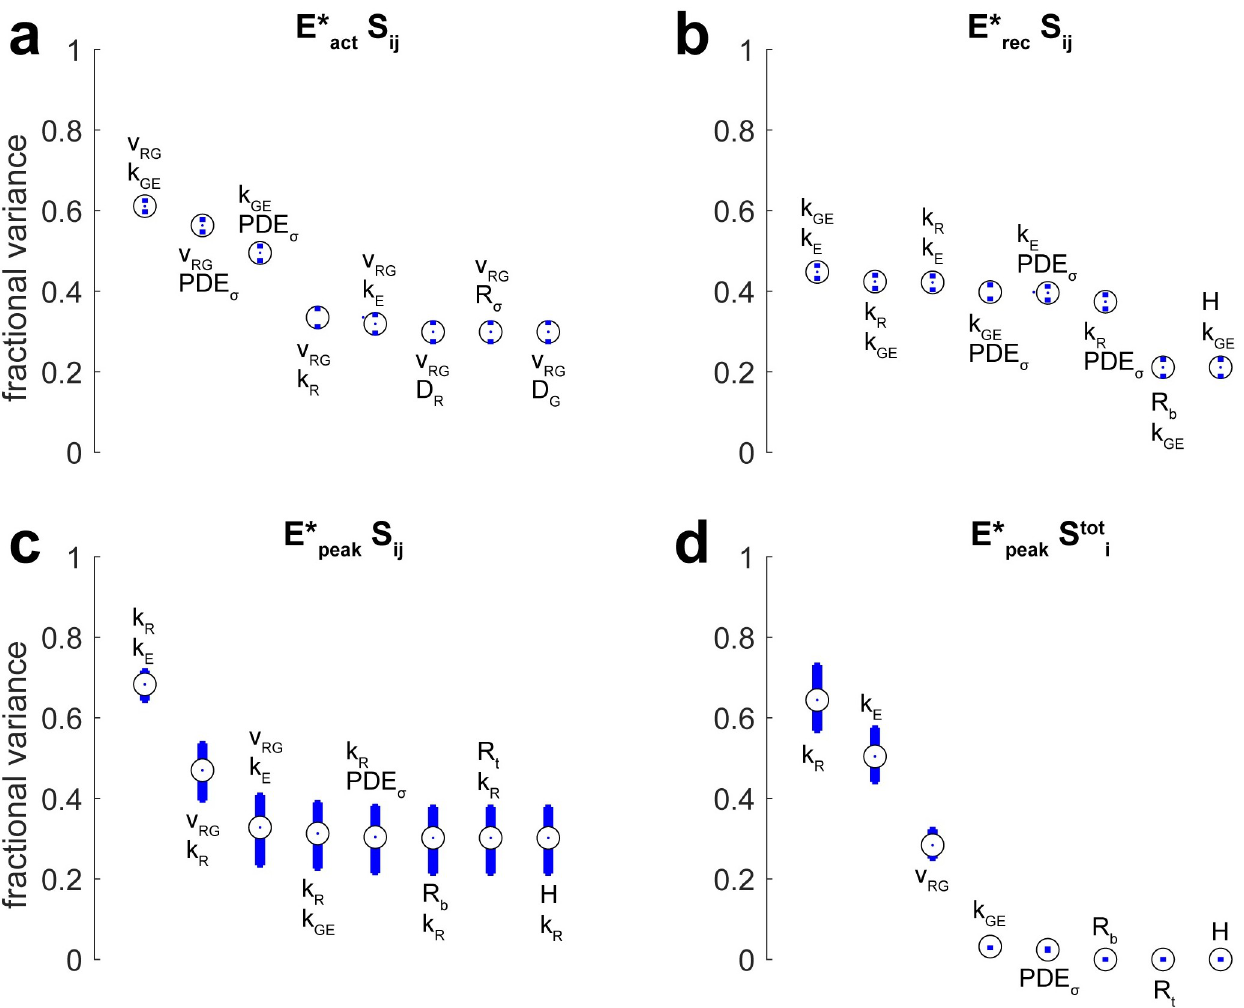
Fig 2. Sobol indices for functionals quantifying E � . The dot at the center of a circle is the Sobol index obtained by Monte Carlo evaluation (100,00 samples). The blue bars define a 90% confidence interval. Plots show the eight most influential parameters ordered from most significant to least significant. (a) Pairwise sensitivity indices for E � activation. (b) Pairwise sensitivity indices for E � recovery. (c) Pairwise sensitivity indices for peak E � production. (d) Total sensitivity indices for peak E �